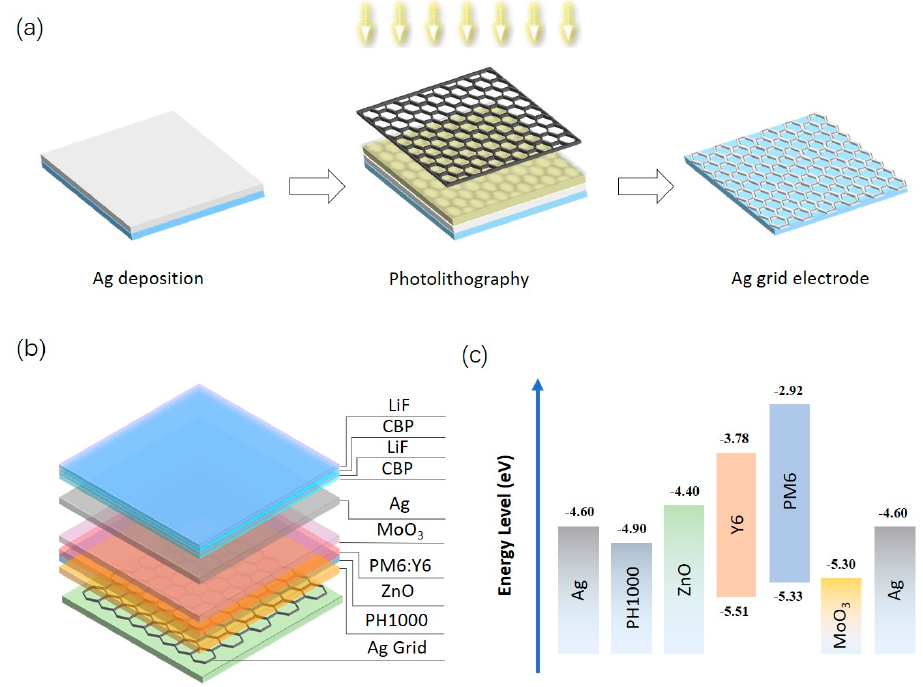
Figure 1. ( a ) Schematic diagram of the manufacturing process of Ag grid electrodes; ( b ) Schematic device structure of the Ag grid ST-OSCs and ( c ) the corresponding energy level diagram.